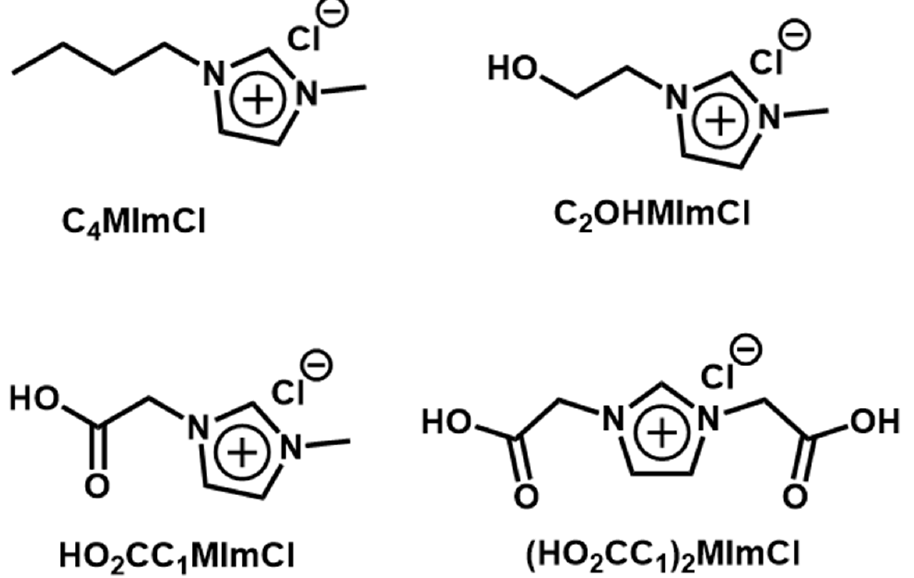
Figure 1. Chemical structures of the IL investigated as compatibilizers for MCC/epoxy composites.